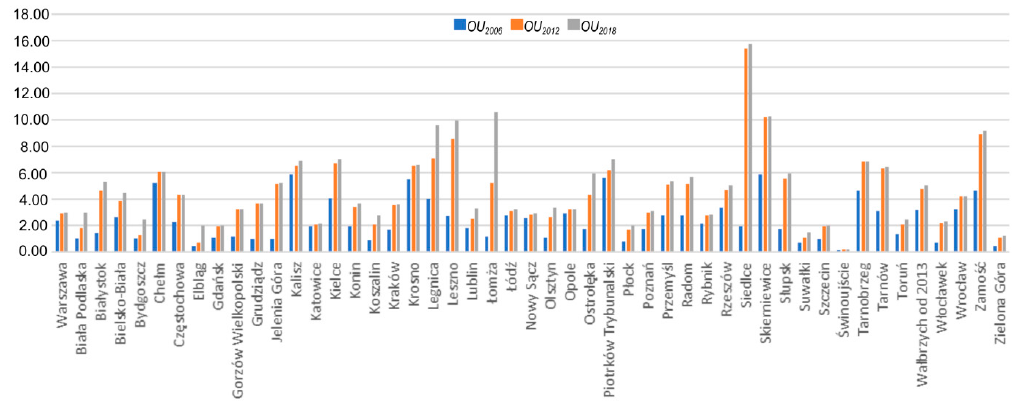
Figure 7. The OU index in the analyzed cities. Source: own elaboration.